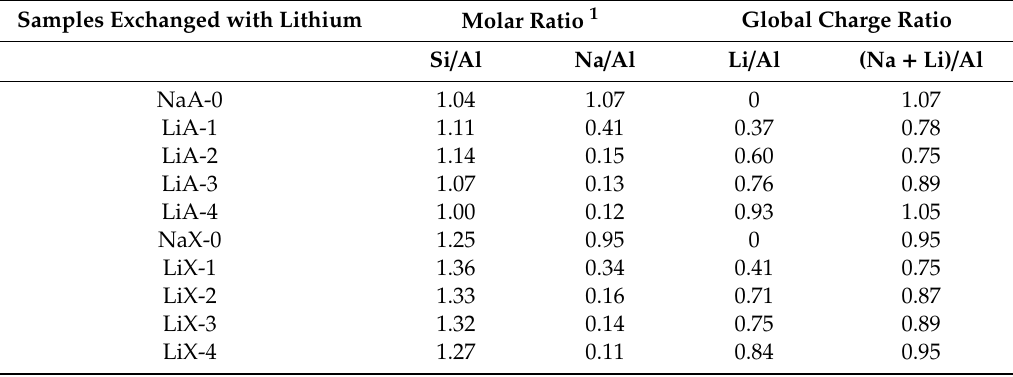
Table 2. Chemical composition of LTA-type and FAU-type zeolites and of its associated lithium form determined by ICP-OES (Si / Al, Na / Al and Li / Al Molar ratio). Samples Exchanged with Lithium Molar Ratio 1 Global Charge Ratio Si / Al Na / Al Li / Al (Na + Li) / Al NaA-0